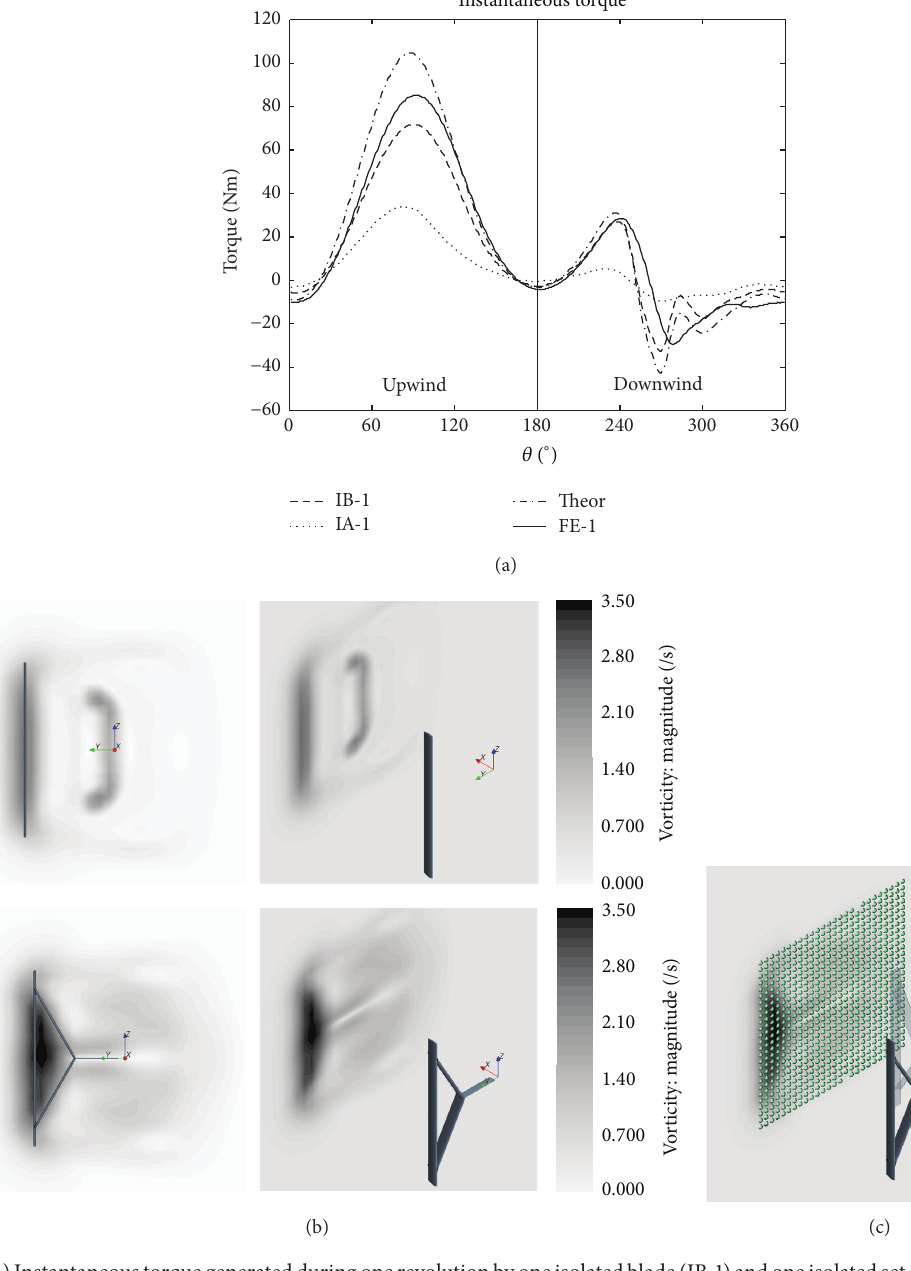
Figure10:(a)Instantaneoustorquegeneratedduringonerevolutionbyoneisolatedblade(IB-1)andoneisolatedsetofarms(IA-1),alongwith theoretical (arithmetical sum of blade and arms torques, IB-1 plus IA-1) and actual (FE-1) entire element results. (b) Comparison of vorticity magnitude maps in a plane behind IB-1 (top) and FE-1 (bottom) configurations. (c) Vorticity in a plane behind the FE-1 configuration (free stream coming from lower right). The rotating element is shown in four subsequent positions during one revolution and the dots represent the grid used for the vorticity maps (see Figure 10(b)) and the quantitative evaluation of wake strength (see Table